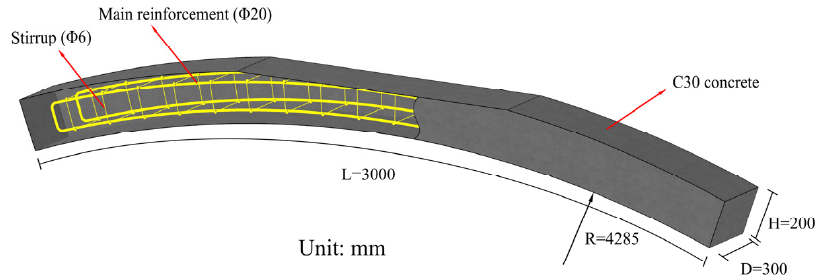
Figure 2. Installation of the steel plate. ( a ) Hoisting steel plate; ( b ) drilling; ( c ) installation of an- chor bolts and adhesive layer; ( d ) final installed plate.